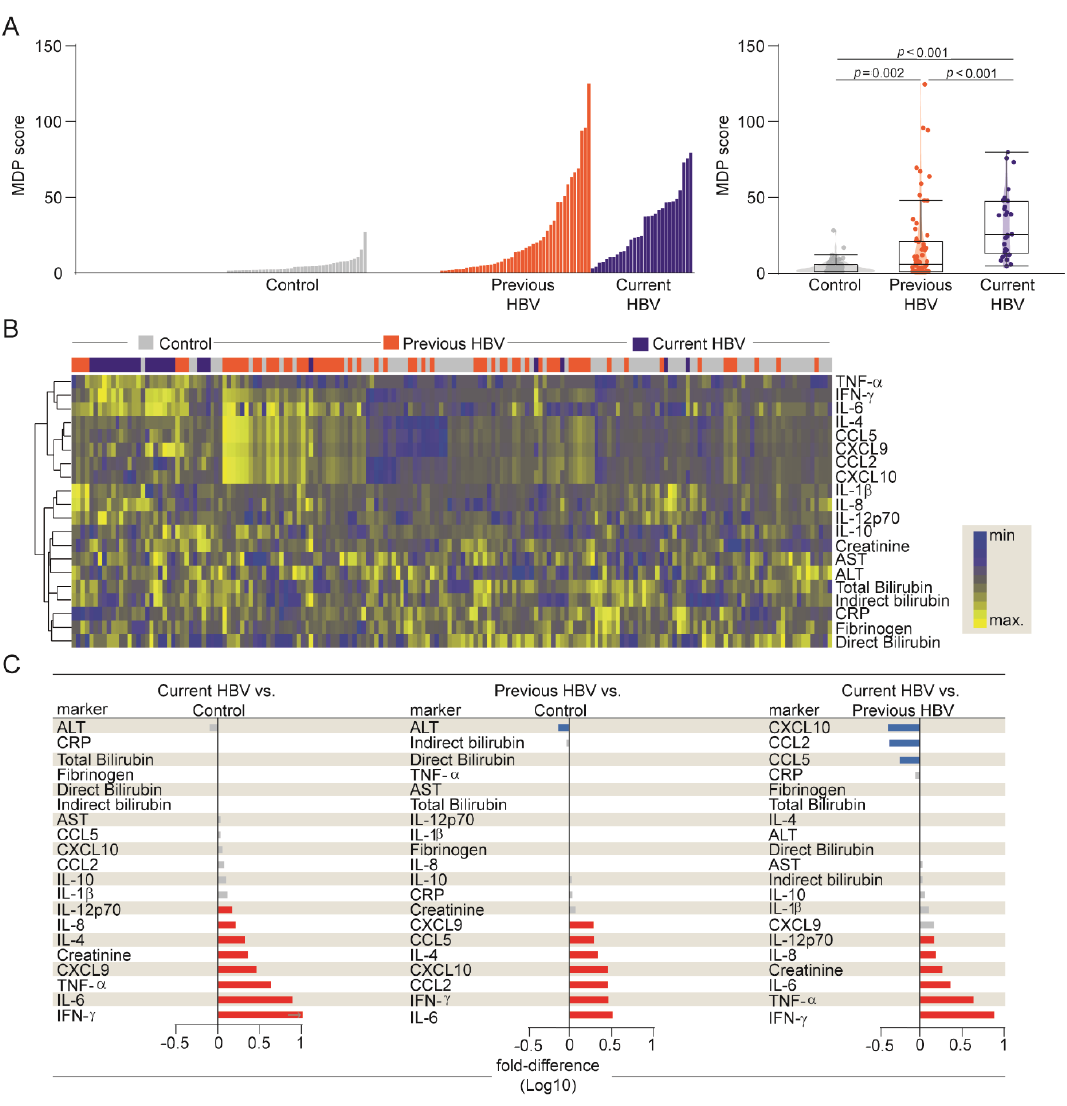
Figure 2. Higher degree of inflammatory perturbation associated with HBV infection. ( A ) Left panel: Histograms show the molecular degree of perturbation (MDP) score values relative to each study group, as indicated. Right panel: Box plots represent the MDP score distribution between study groups. Values were compared between patient groups using the Kruskal–Wallis test. ( B ) A hierarchical cluster analysis (Ward’s method) was employed to show the molecular degree of perturbation of each individual biochemical marker. ( C ) Average fold-di ff erence values of the MDP scores for each marker were calculated between clinical groups. Red and blue bars represent statistically significant differences estimated by the Mann–Whitney U test. Abbreviations (alphabetic order): ALT: alanine aminotransferase; AST: aspartate aminotransferase; CCL: C-C motif chemokine ligand; CXCL: C-X-C motif chemokine ligand; CRP: C-reactive protein; IFN: interferon; IL: interleukin; TNF: tumor necrosis factor.